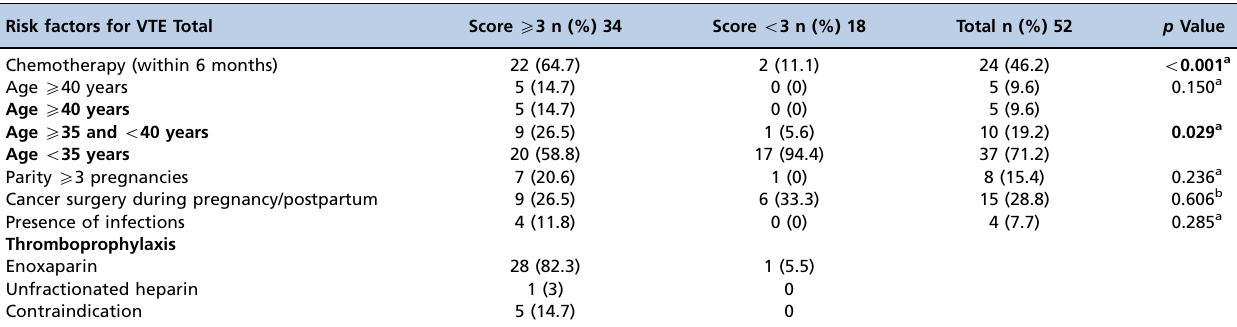
Table 3 - Risk factors in pregnant patients with cancer and a VTE risk score X 3 (high risk) or a VTE risk score o 3 (HC-FMUSP,